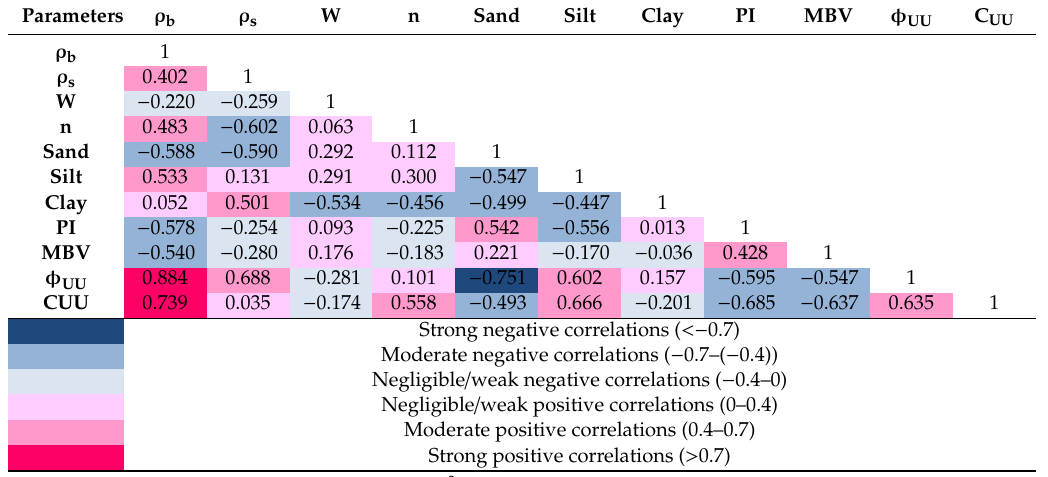
Table 3. Correlation matrix visualizing Pearson’s coe ffi cients for geomechanical properties. Parameters ρ